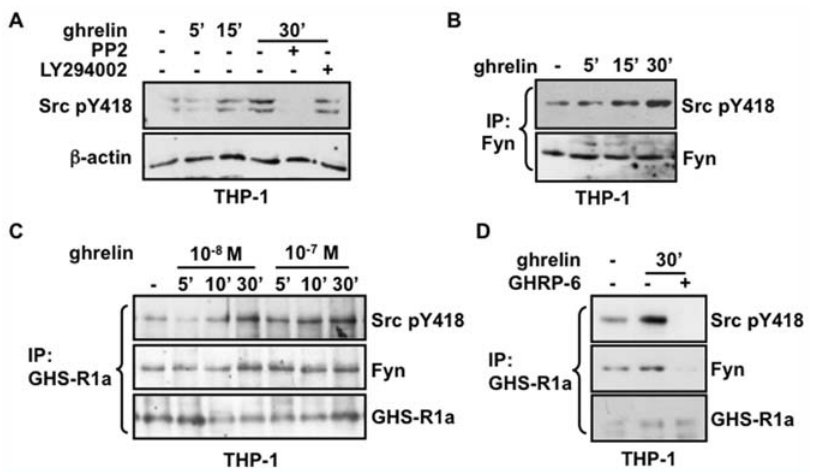
Figure 4. Induced recruitment and activation of Fyn kinase to the GHS-R1a receptor by ghrelin. ( A ) Ghrelin activates Src-related kinases. Differentiated THP-1 cells were serum-deprived for 16 h and incubated with 1 m M Src-related kinase inhibitor PP2 or 10 nM PI3-K inhibitor LY-294002 for 30 min before incubation with 10 nM ghrelin for the indicated times. The lysates were then analyzed by immunoblot with an anti-phospho-specific to Src Tyr-418, the activation loop site, and loading was monitored with a b -actin antibody. ( B ) Ghrelin promotes Fyn activation in THP-1 macrophages. Cells were treated as in (A) and extracts were immunoprecipitated with an antibody against Fyn, and analyzed by immunoblot using anti-Src-pY418 and anti-Fyn antibodies. ( C ) Fyn is recruited to the GHS-R1a receptor and activated by ghrelin. THP-1 cells were treated similar as in (A) and immunoprecipitation was carried out with an antibody against GHS-R1a, and analyzed by immunoblot using anti-Src-pY418 and anti-Fyn antibodies. Samples were normalized with an anti-GHS-R1a antibody. ( D ) Effect of GHS-R1a inhibition on Fyn recruitment and activation. Serum deprived THP-1 cells were pretreated with 100 nM D -Lys 3 -GHRP-6 for 30 min, followed by incubation with 10 nM ghrelin for 30 min, and then analyzed as in (C).